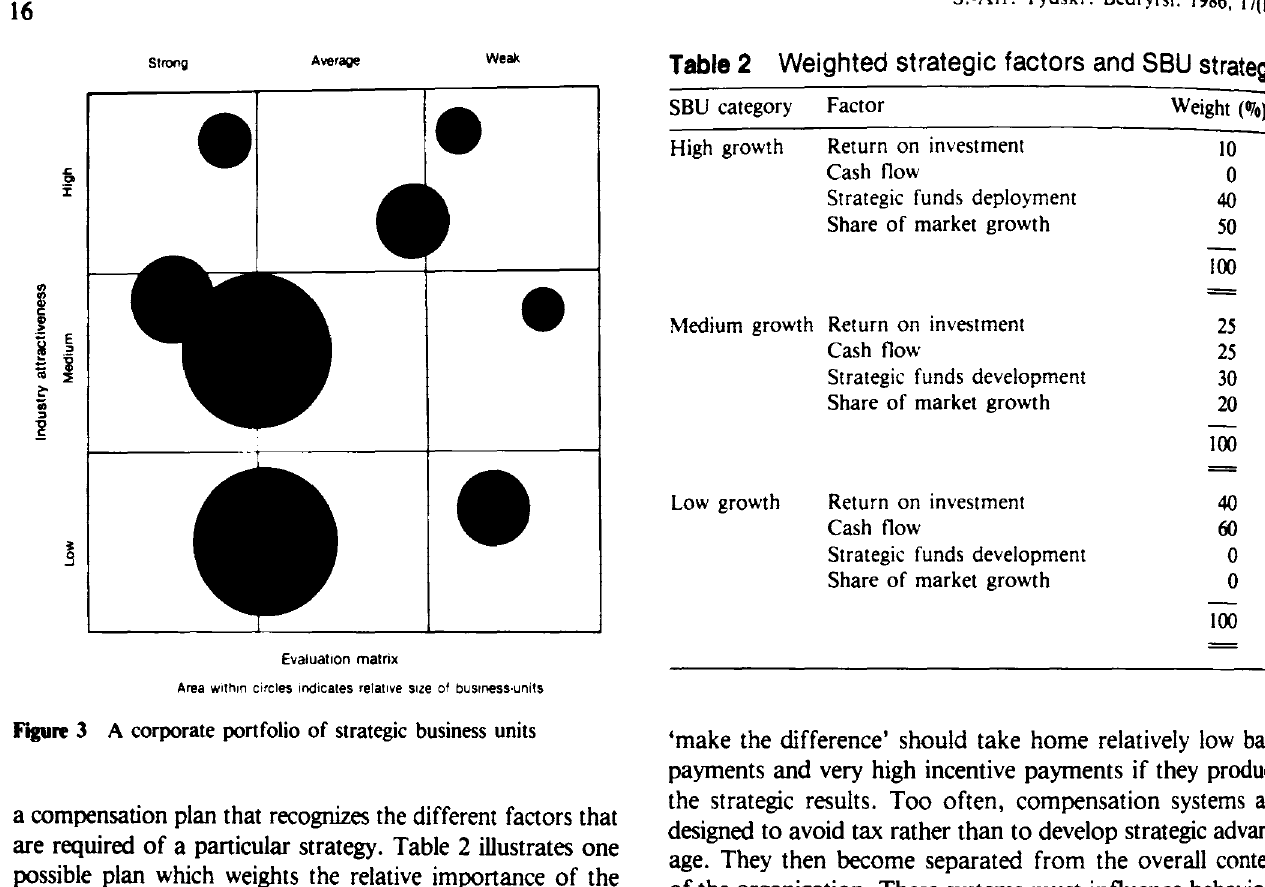
Weighted strategic factors and SBU